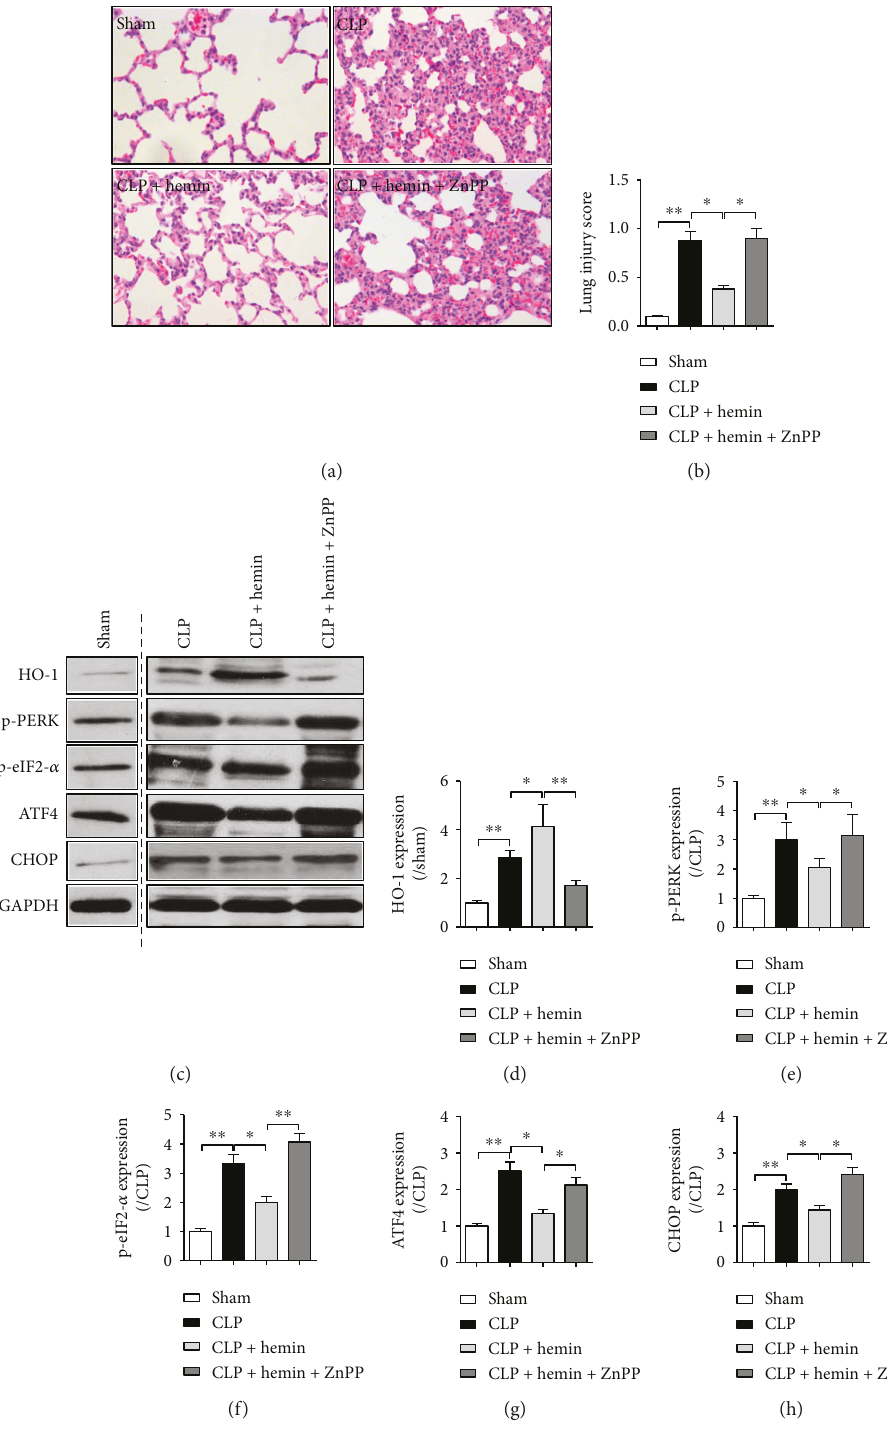
Figure 3: HO-1 activation could inhibit endoplasmic reticulum stress and reduced ER stress-related lung injury. Sprague-Dawley rats were intraperitoneally injected with saline, hemin (30 mg/kg) 24 h before operation with or without ZnPP (20 mg/kg) 12h after hemin was given, then received celioectomy with or without CLP surgery. (a) Lung pathology was detected by using hematoxylin and eosin (H&E) staining. (b) Levels of lung injury score. Lung injury score evaluations were due to the pathology in lung H&E staining. (c – h) Levels of endoplasmic reticulum stress-related proteins, that is, HO-1, p-PERK, p-eIF2- α , ATF4, and CHOP, were detected using Western blot method, and gray analysis were performed according to the bands. p-PERK, phosphorylated PERK; p-eIF2- α , phosphorylated eIF2- α . Data are shown as mean ± SEM ( n = 6 ). ∗ P < 0 05 and ∗∗ P < 0 01 ; one-way ANOVA Tukey ’ s post hoc